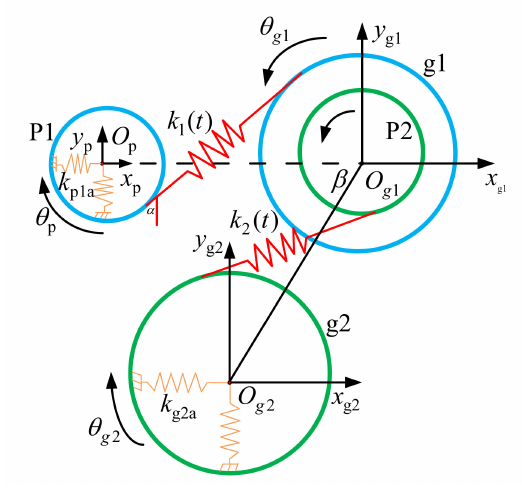
Figure 19. Two-stage meshing